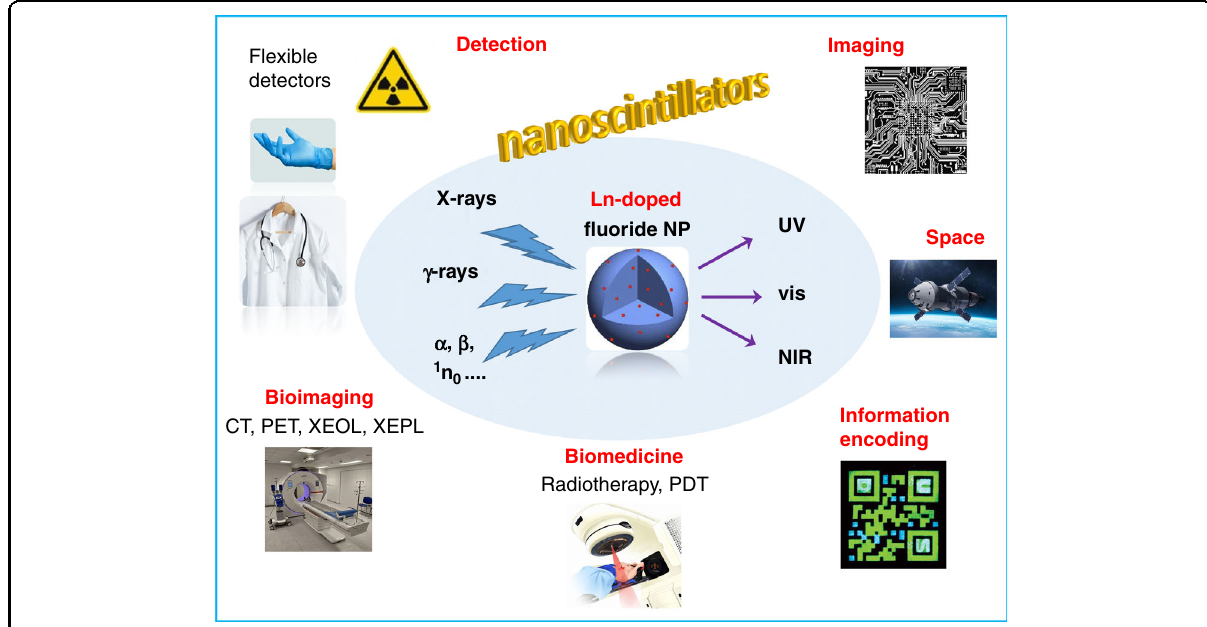
Fig. 1 Main applications of nanoscintillators. Key. NP nanoparticle, CT computed tomography, PET positron-emission tomography, XEOL X-ray excited optical luminescence, XEPL X-ray excited persistent luminescence, PDT photodynamic